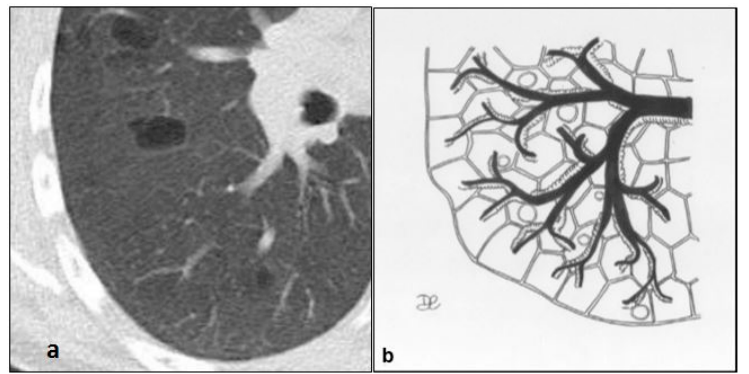
Figure 8. LIP cysts pattern ( a ): multiple cysts, with size ranging from 10 to 30 millimeters and thin walls, predominantly in peribroncovascular regions ( b ).